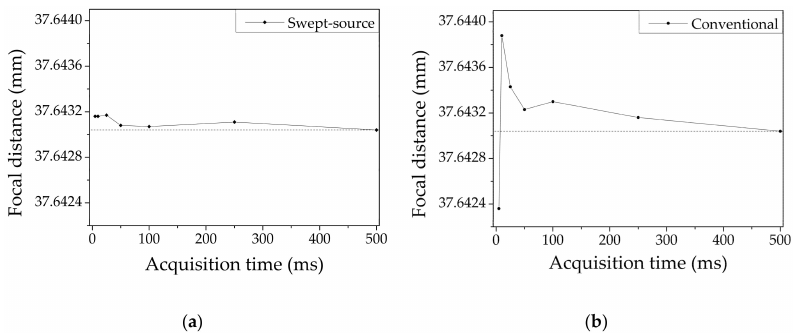
Figure 4. Relative distribution of the measured axial positions of the target surface as a function of the acquisition time for the ( a ) SS-CCM and ( b ) the conventional